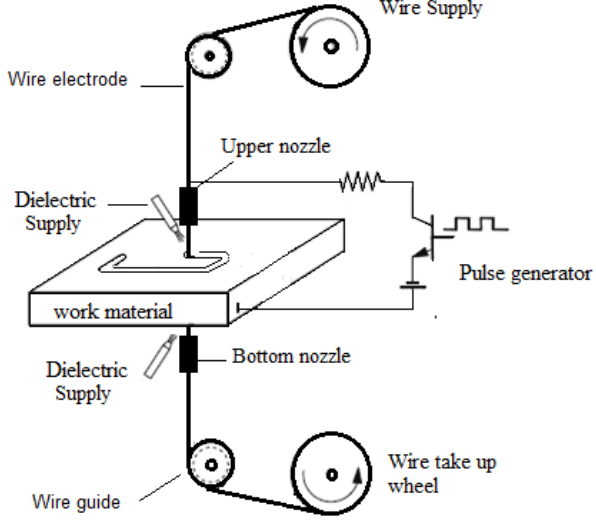
Figure 1. Representation of WEDM